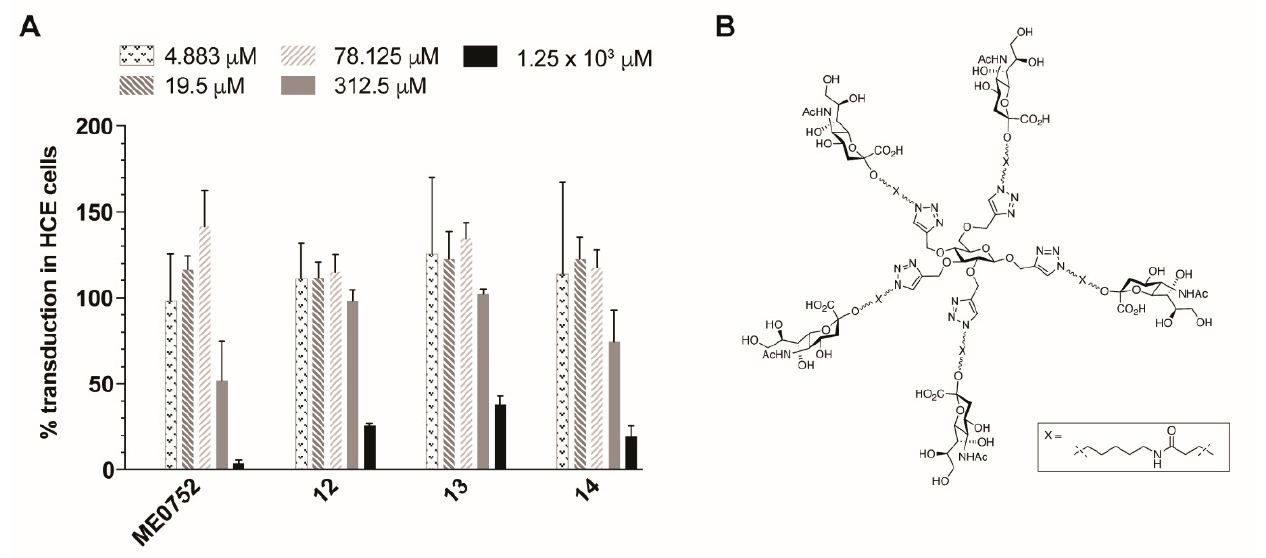
Figure 2. Effect of scaffold replacement on CVA24v transduction in HCE cells. ( A ) Effect of scaffold-replaced pentavalent Neu5Ac conjugates 12–14 on CVA24v transduction in HCE cells at 37 °C. Error bars are shown as the standard error of the mean (SEM). Data are presented as the % of control, that is, the value obtained in the absence of an inhibitor. All experiments were performed in duplicate and for a minimum of two times. ( B ) Structure of glucose-based pentavalent Neu5Ac conjugates ME0752 .